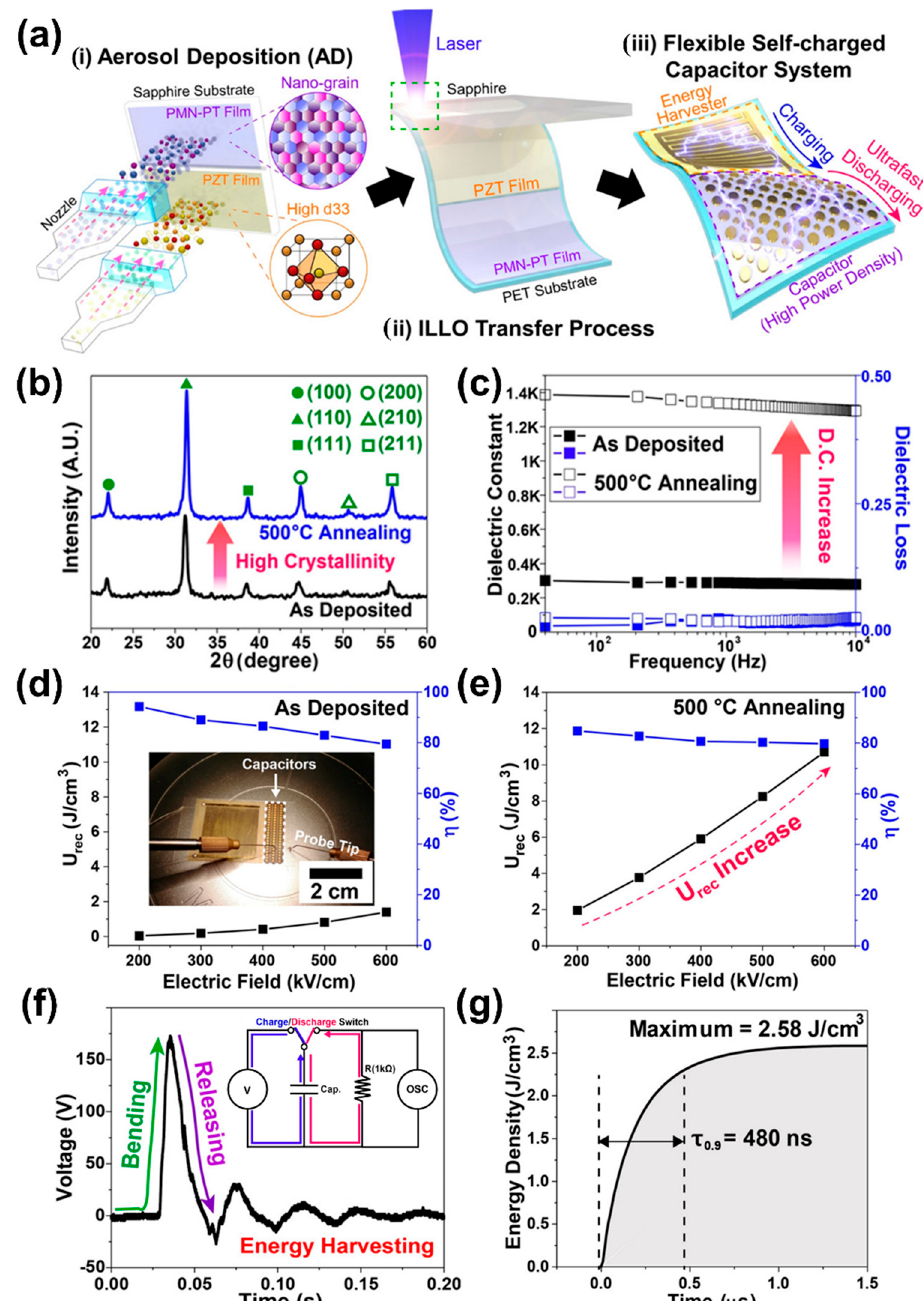
Figure 13. ( a ) Schematic representation of the fabrication process of flexible SUHP capacitor system. ( i ) Aerosol deposition of PMN − PZT and PZT films on sapphire substrates. ( ii ) Transferring PMN − PT and PZT films on sapphire substrates onto a flexible PET substrate by ILLO process. ( iii ) Deposition of IDEs, MIM electrodes and protective layer for flexible SUHP capacitor system. ( b , c ) XRD patterns and dielectric properties as a function of the frequency of as-deposited and annealed PMN − PT films. Recoverable energy density (U rec ) and energy storage efficiency ( η ) response versus applied electric field of ( d ) as − deposited and ( e ) annealed PMN − PT thick film capacitors. ( f , g ) The output voltage response and discharged energy density from the SUHP capacitor system under bending/unbending motions by human fingers. A circuit diagram of the charging − discharging measurement system is shown in the inset of ( f ). Reproduced with permission [155].